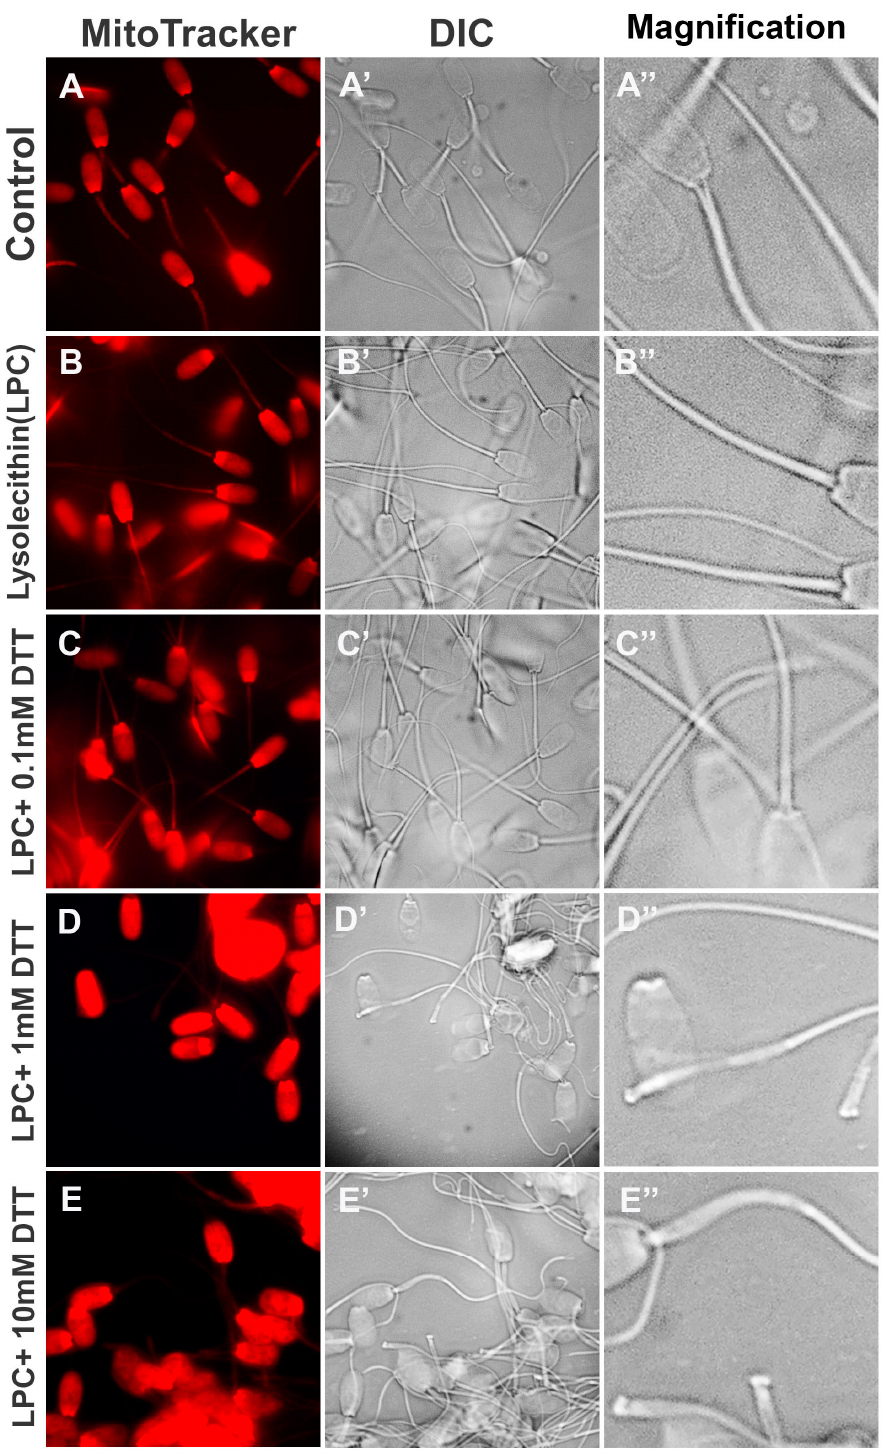
Figure 1. Sequential demembranation and reduction in sperm protein disulfide bonds prime sperm mitochondria for co-incubation with oocyte extracts. Spermatozoa, pre-labeled with MitoTracker, were demembranated with 0.05% lysolecithin and subsequently incubated with various DTT con- centrations (0.0, 0.1, 1.0, and 10.0 mM) ( A – E ). The morphological changes of sperm mitochondria were not obvious after the incubation of spermatozoa with 0.05% lysolecithin alone ( B’ , B’’ ) com- pared to membrane-intact control spermatozoa ( A’ , A’’ ). Incubation with 0.05% lysolecithin fol- lowed by 0.1 mM DTT still showed intact sperm mitochondrial sheaths ( C’ , C’’ ), while incubation